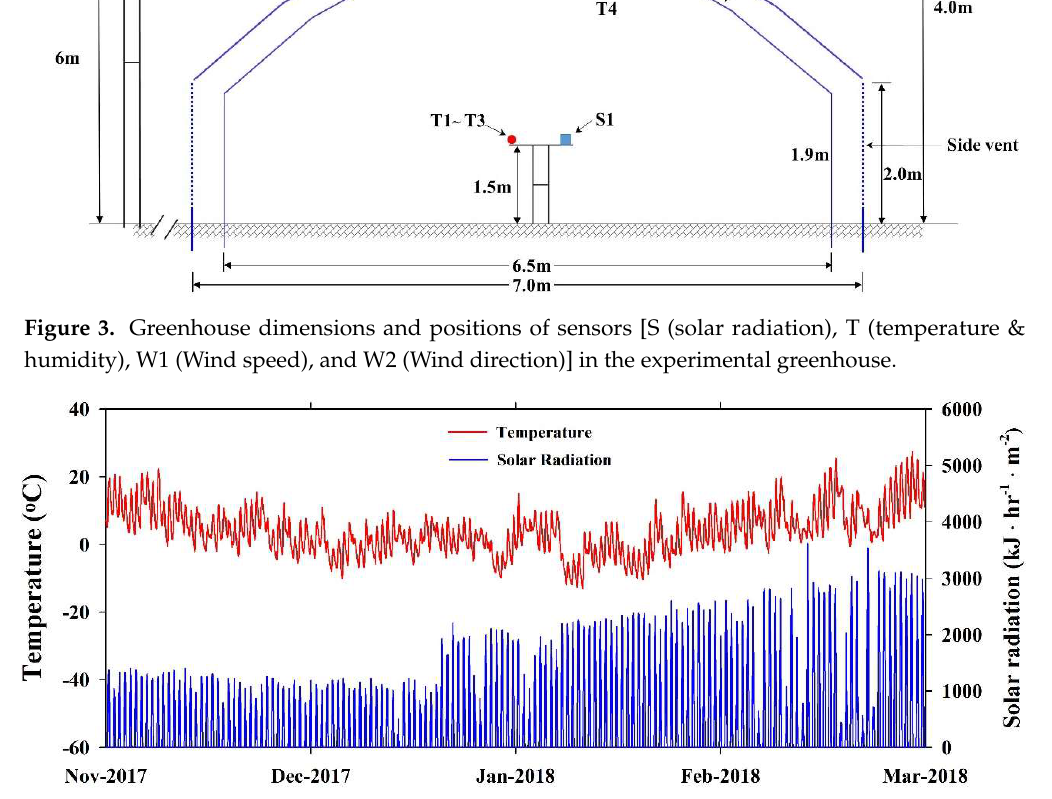
Figure 4. Temperature and solar radiation outside the greenhouse during the winter season of November 2017 to March